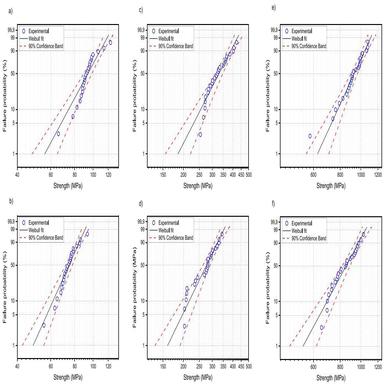
Experimental values and the associated probabilities together with Weibull distributions of the strengths calculated using σθ and m and the corresponding 90% confidence bands for the three materials characterized in this work. a) PZT, t = 0.5 mm b) PZT, t = 1 mm c) Al2O3, t = 0.5 mm d) Al2O3, t = 0.8 mm e) Si3N4, t = 0.5 mm f) Si3N4, t = 1 mm.